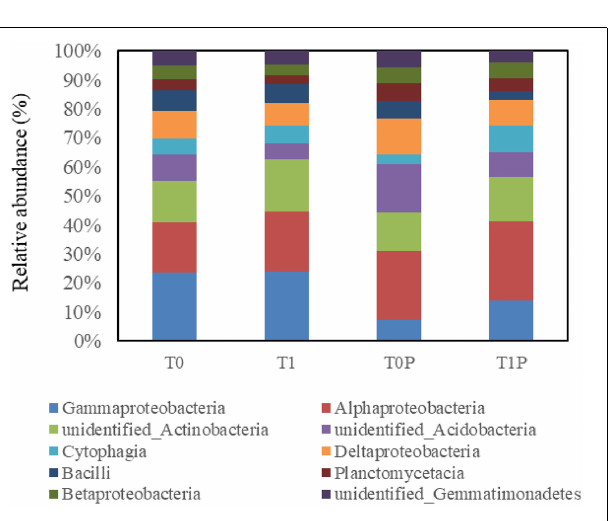
FIGURE 5 | Effects of rock phosphate (RP) and phosphate-solubilizing bacteria (PSB) on the relative abundance (%) of the 10 dominant classes of soil bacteria. The same 10 classes were dominant in all treatments. Treatments (following the treatment code is the replicate number): T0, no additions, the control; T0P, with PSB inoculation only; T1, with RP amendment only; T1P, with RP and PSB.